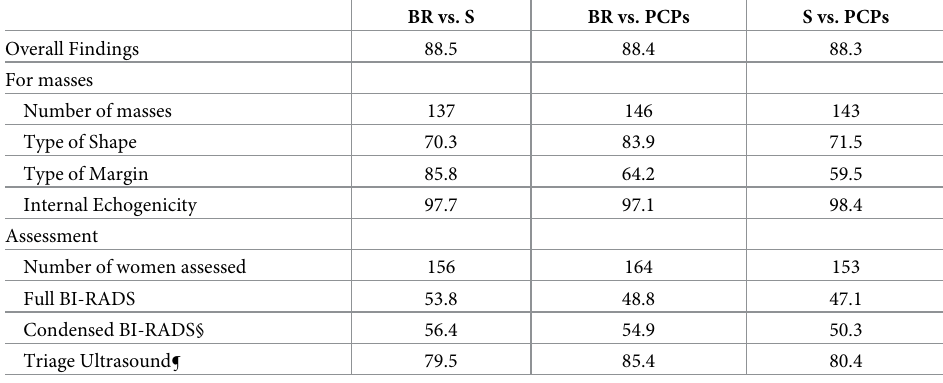
Table 2. Inter-observer percent agreement for BI-RADS lexicon use and assessment.